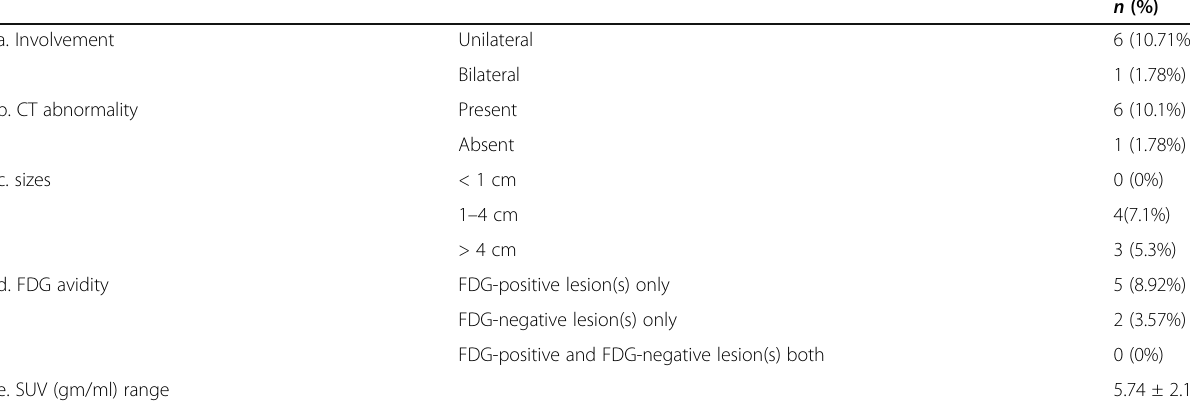
Table 10 Characteristics of adrenal gland metastases, n = 56